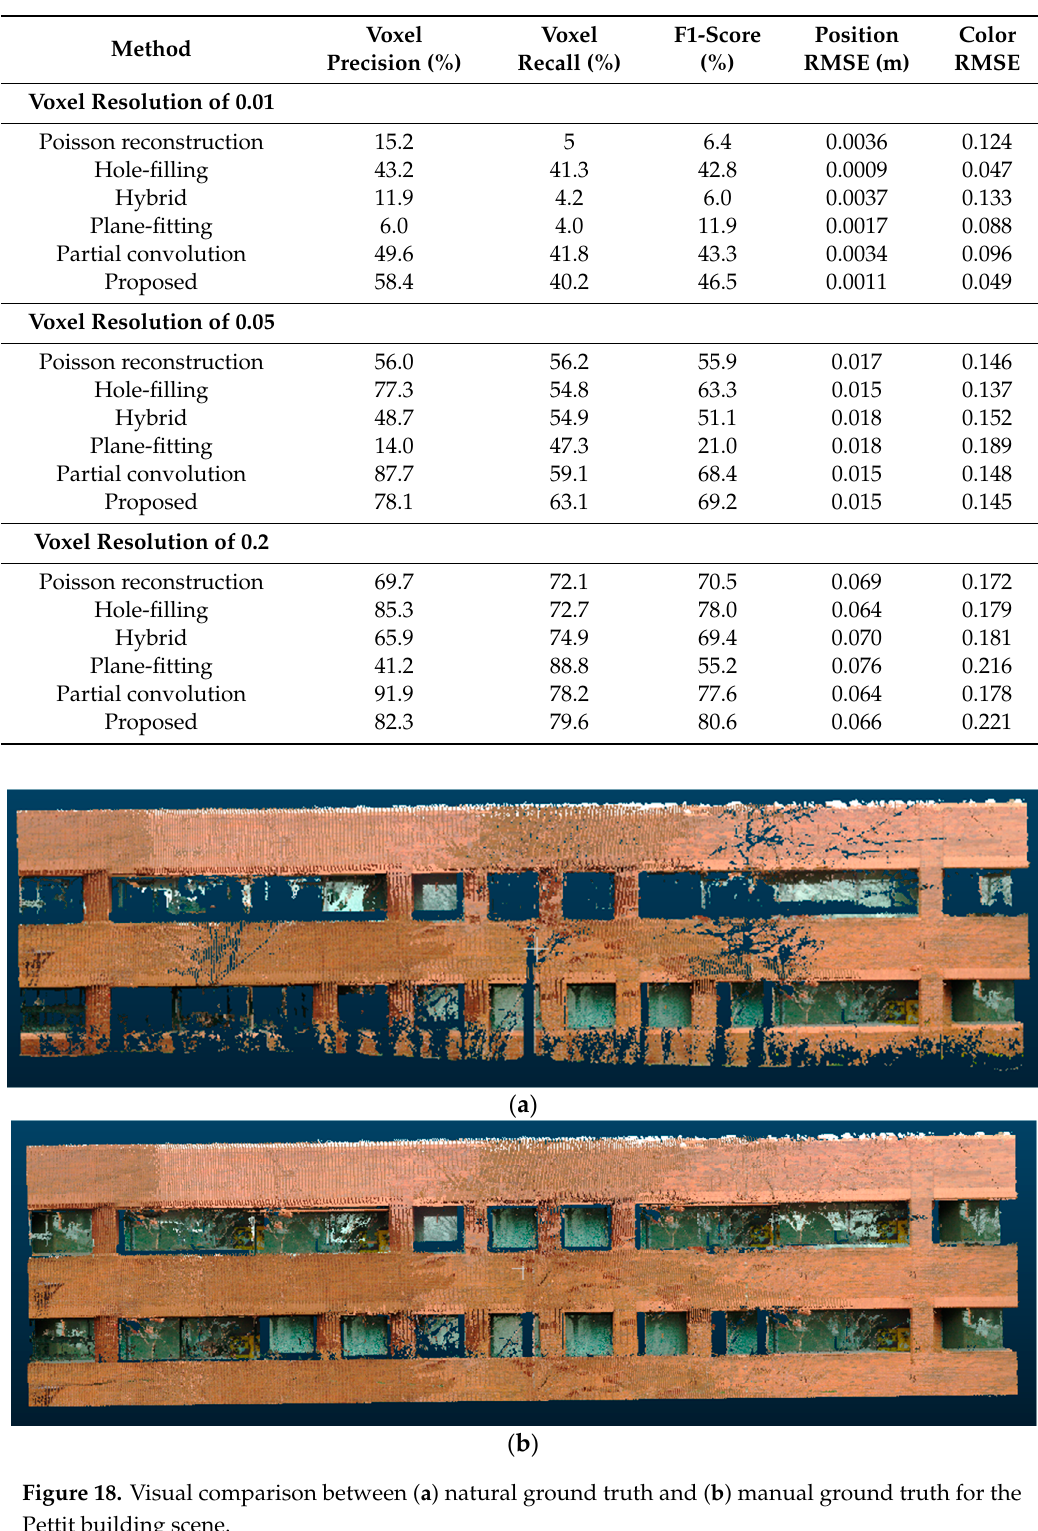
Table5. Performancecomparisonbetweenusingdifferentvoxelresolutionsaveragedoverallelevenscenes.